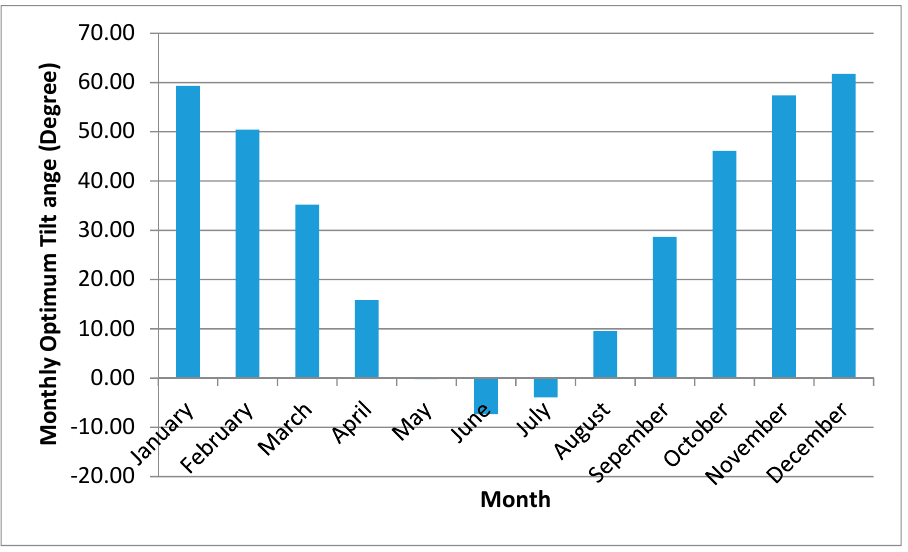
Figure 6. The monthly optimum tilt angle β opt,m for Jerusalem, Palestine.